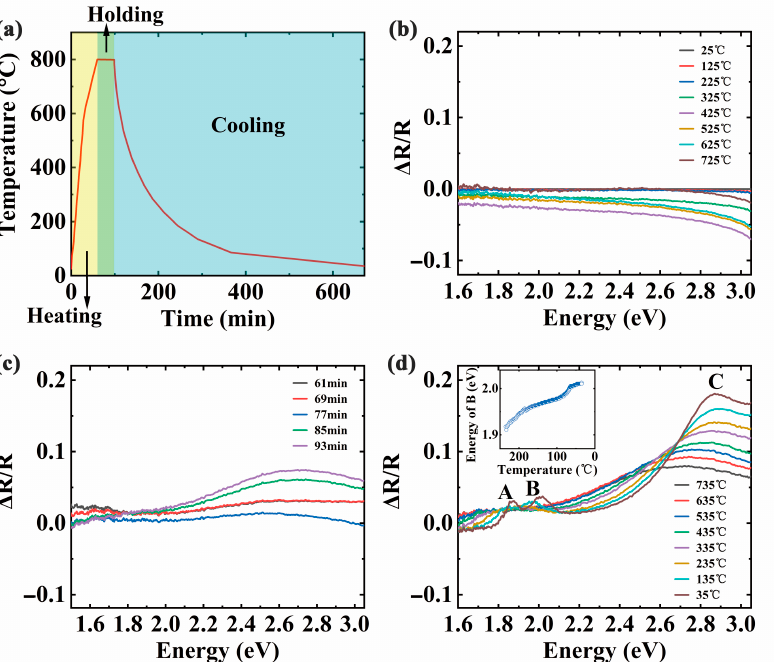
Figure 2. ( a ) The temperature profile during the growth of molybdenum disulfide (MoS 2 ) flakes using chemical vapor deposition (CVD); ( b – d ) In-situ differential reflectance spectroscopy (DRS) of the heating, holding, and cooling sections during the CVD growth, respectively. The inset in ( d ) is the variation of peak B with temperature. A, B, and C represent three characteristic peaks of MoS 2 at different energy, respectively.